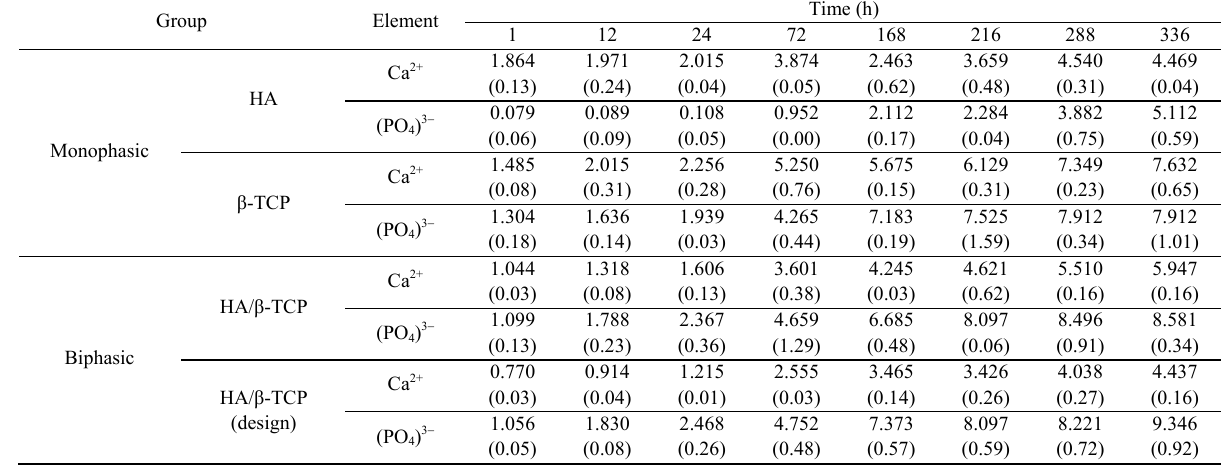
Table 2 Ca and PO 4 mean concentration as released from the mono- and bi-phasic scaffold groups; the standard deviations are noted in